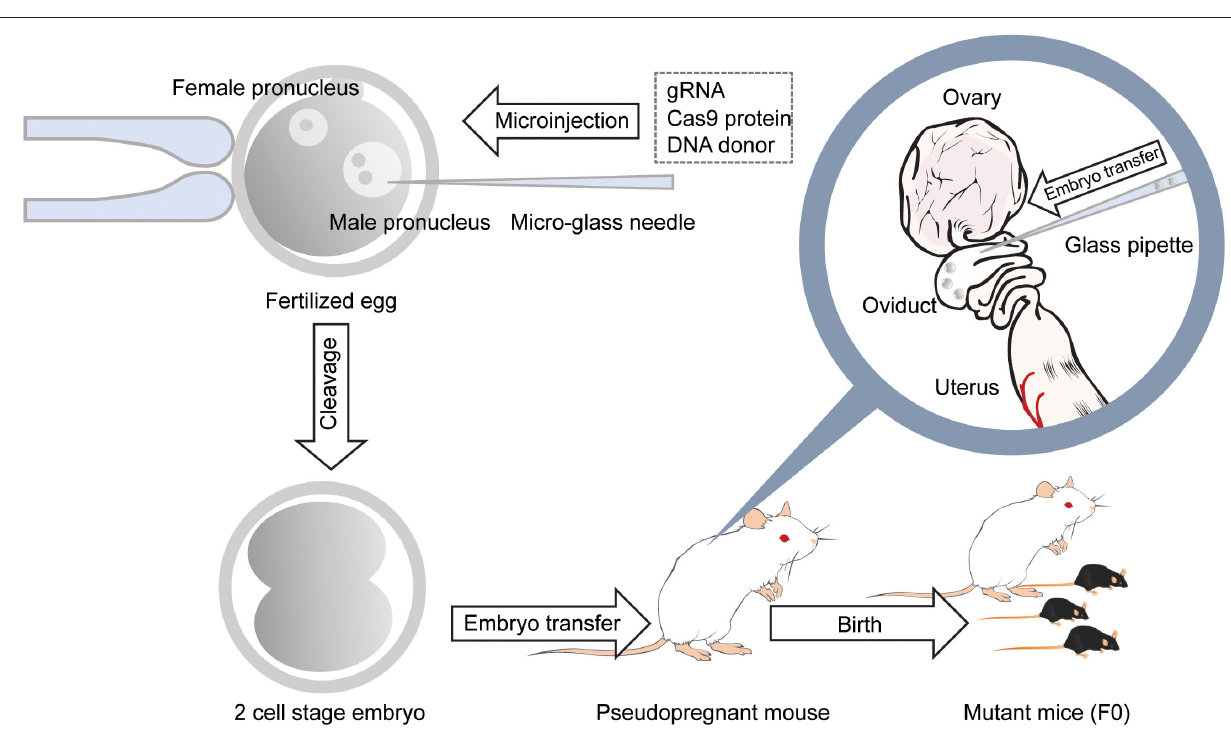
via oviductal nucleic acids delivery (iGONAD), was achieved by injecting gRNA and Cas9 protein into the oviduct and apply electroporation voltage through a pair of electrical pads ( Figure 4